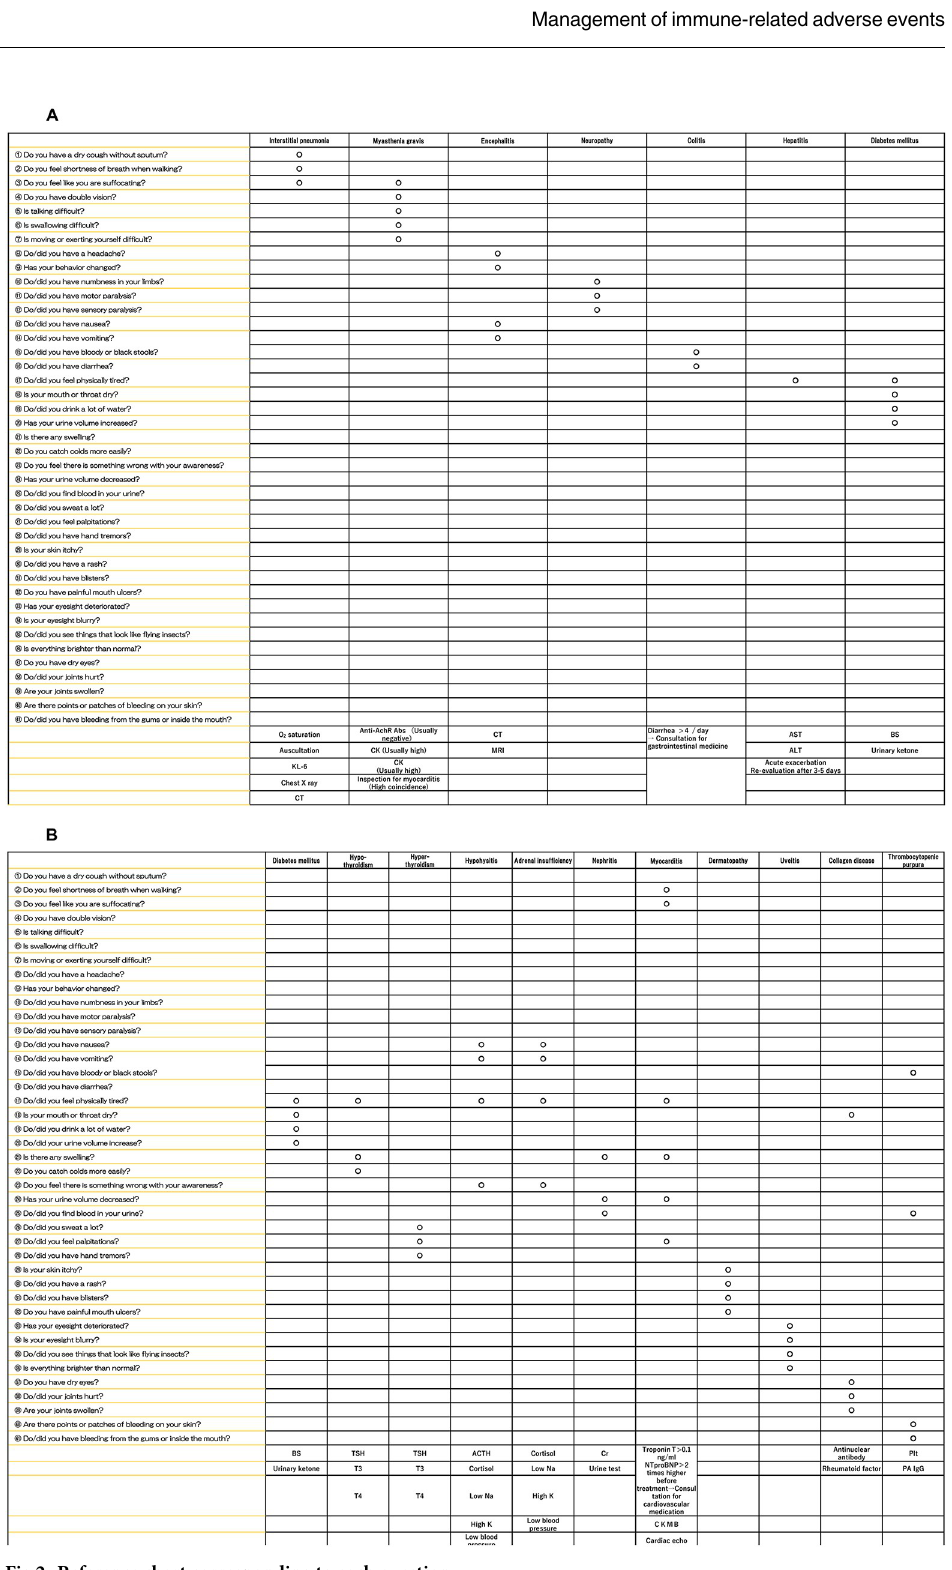
Fig 2. Reference chart corresponding to each